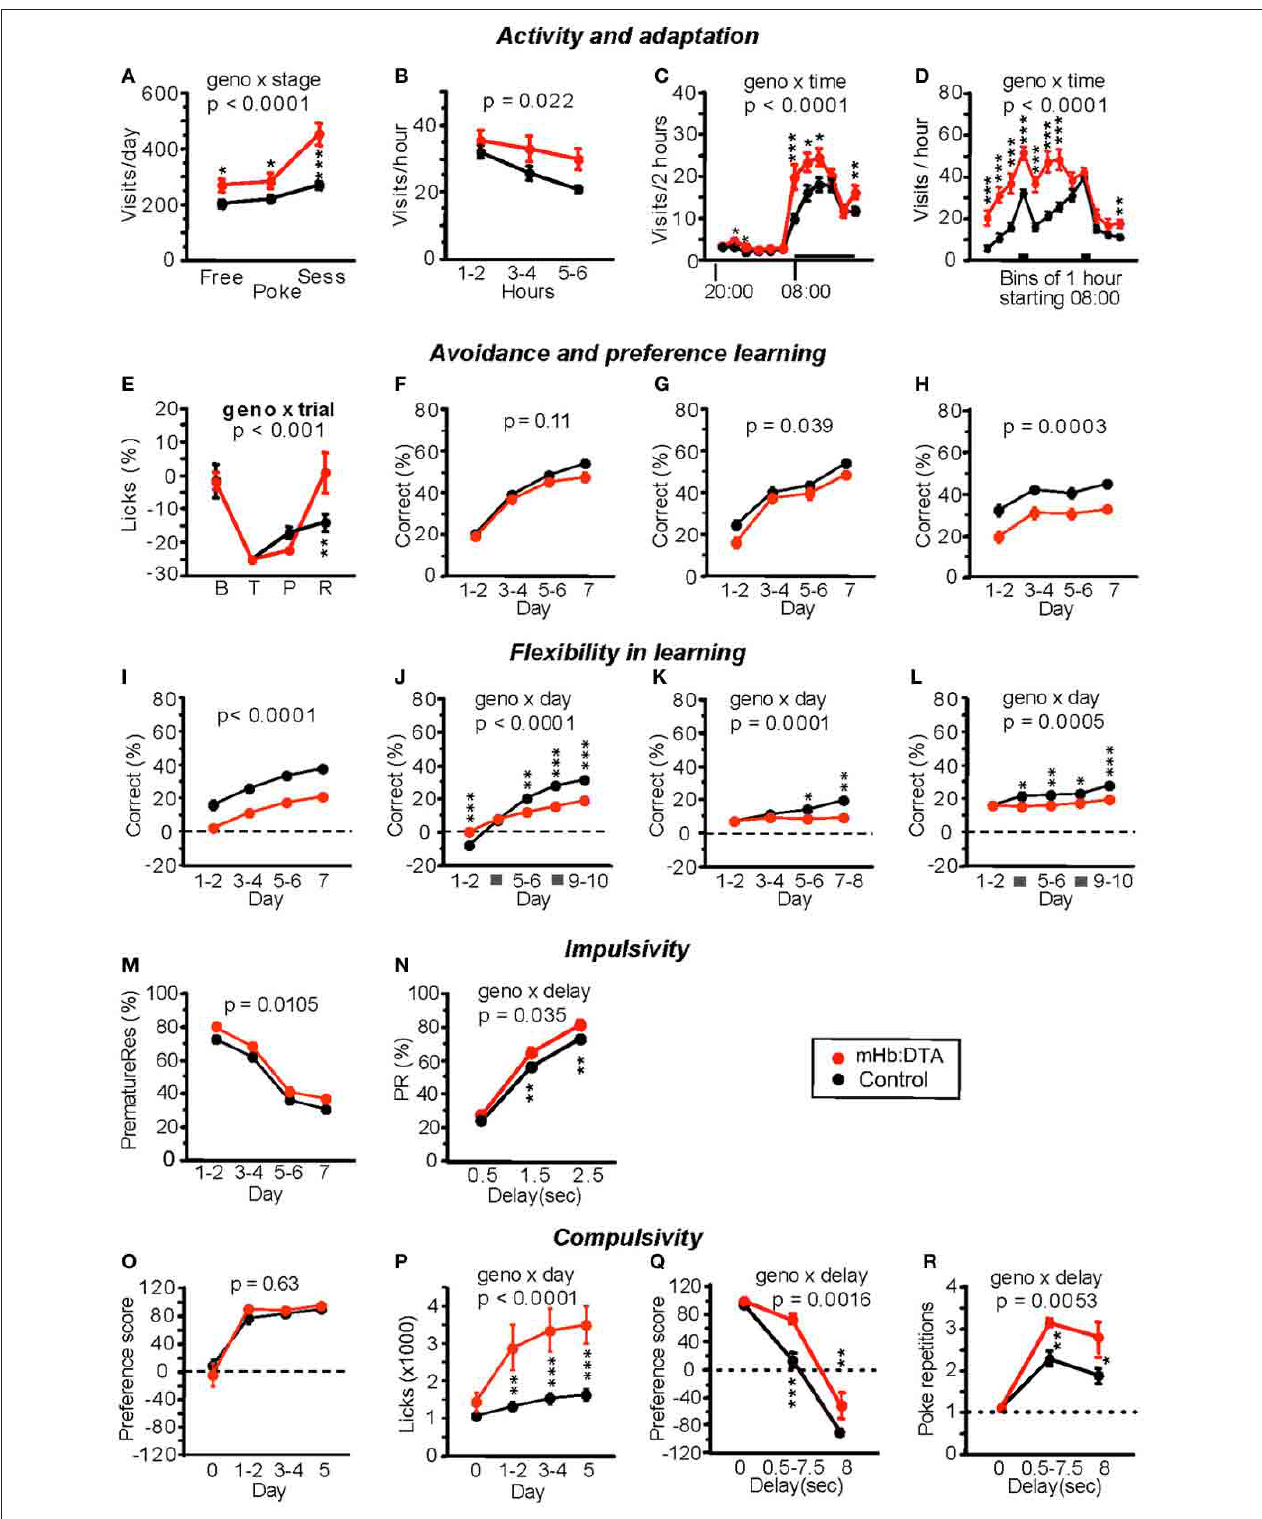
FIGURE 6 | Behavioral phenotypes of mHb:DTA mice in the IntelliCage system. (A–D) Activity and adaptation. (A) Total mean visits per day during the second to last day of free, nose-poke, and session adaptation (mice were 4–5 months old, n = 12 for mHb:DTA and 24 for controls). The mHb:DTA